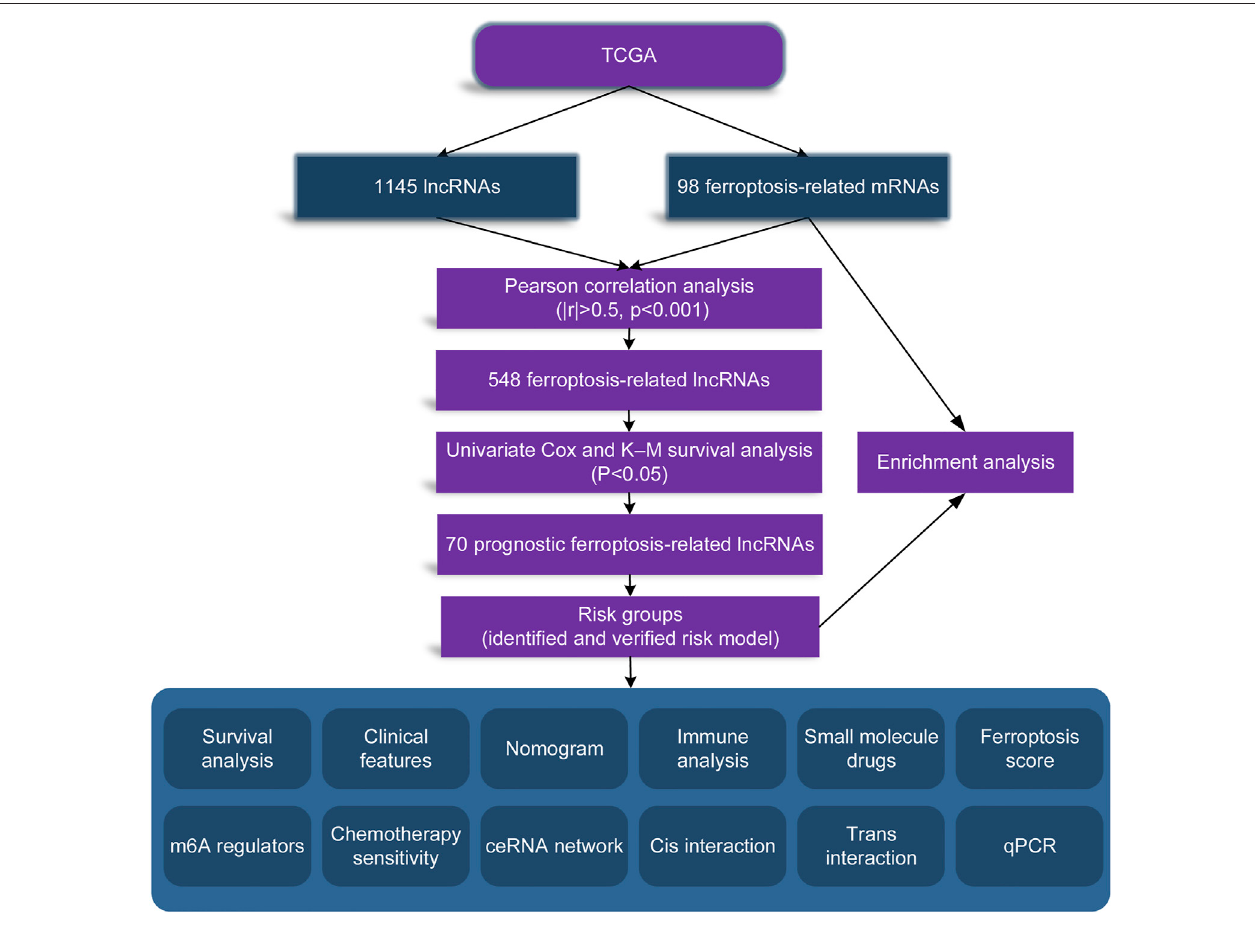
FIGURE 1 | Flow diagram of our